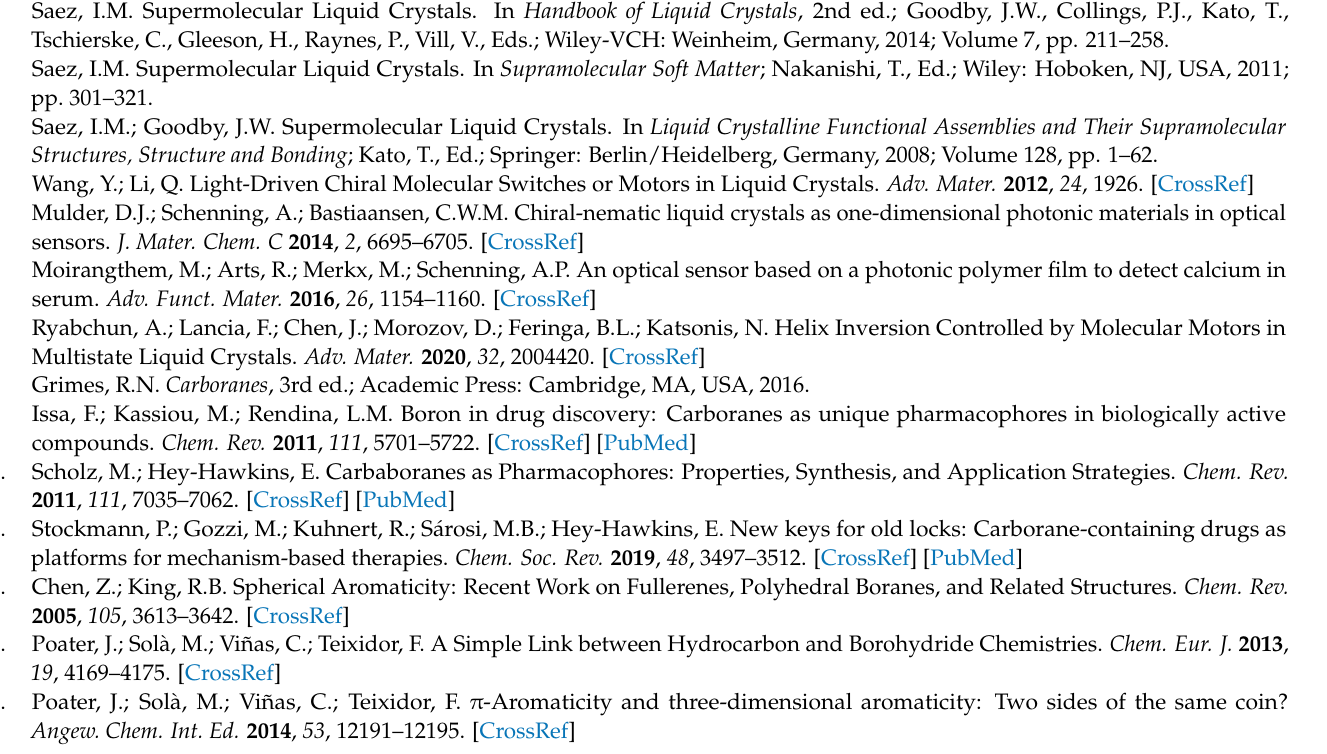
of M2 (A), M3 (B) and M5 (C) are shown in the left. Detail view of molecular self-assembly is shown in the right. Independent molecules in the unit cells are colored. H atoms are omitted for clarity, Figure S19. Comparison between 2D fingerprint plots for M2 (A), M3 (B) and M5 (C), Figure S20. Normalized UV-Visible and fluorescence spectra of M2-M3 and M5 , Figure S21. DSC of compound M2 (3 cycles at 10 ◦ C/min), Figure S22. DSC of compound M3 (3 cycles at 10 ◦ C/min), Figure S23. DSC of compound M4 (3 cycles at 10 ◦ C/min), Figure S24. DSC of compound M5 (3 cycles at 10 ◦ C/min), Figure S25. Selected POM images of compound M2 . Left side: Registered at 132 ◦ C during the cooling cycle (rate 1 ◦ C/min), showing N* phase. Right side: Registered at 119 ◦ C during the cooling cycle (rate 1 ◦ C/min), showing the transition from N* to crystalline phase, Figure S26. Selected POM images of compound M5 , registered at 204.3 ◦ C during the cooling cycle (rate 0.5 ◦ C/min), showing N* phase from Isotropic, Table S1. Crystal and Structure Refinement data for M2 , M3 and M5 , Table S2. Selected bond lengths for M2 , M3 and M5 , Table S3. Bond lengths for M2 , M3 and M5 , Table S4. Bond angles for M2 , M3 and M5